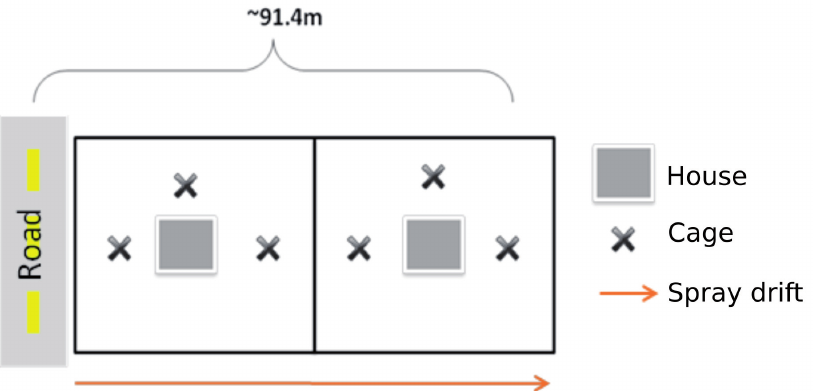
Figure 2. Placement of sentinel cages at Clovis residences to evaluate the control efficacy of aerial truck mounted ULV deltamethrin (DeltaGard®) application. Distance between the sentinel cages from the street to the furthest sentinel in the front yard of the next parallel street was 91.44